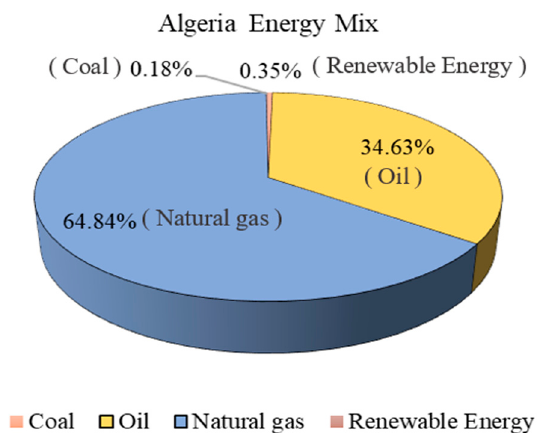
Figure 5. Algeria fossil fuel generation mix in 2019.